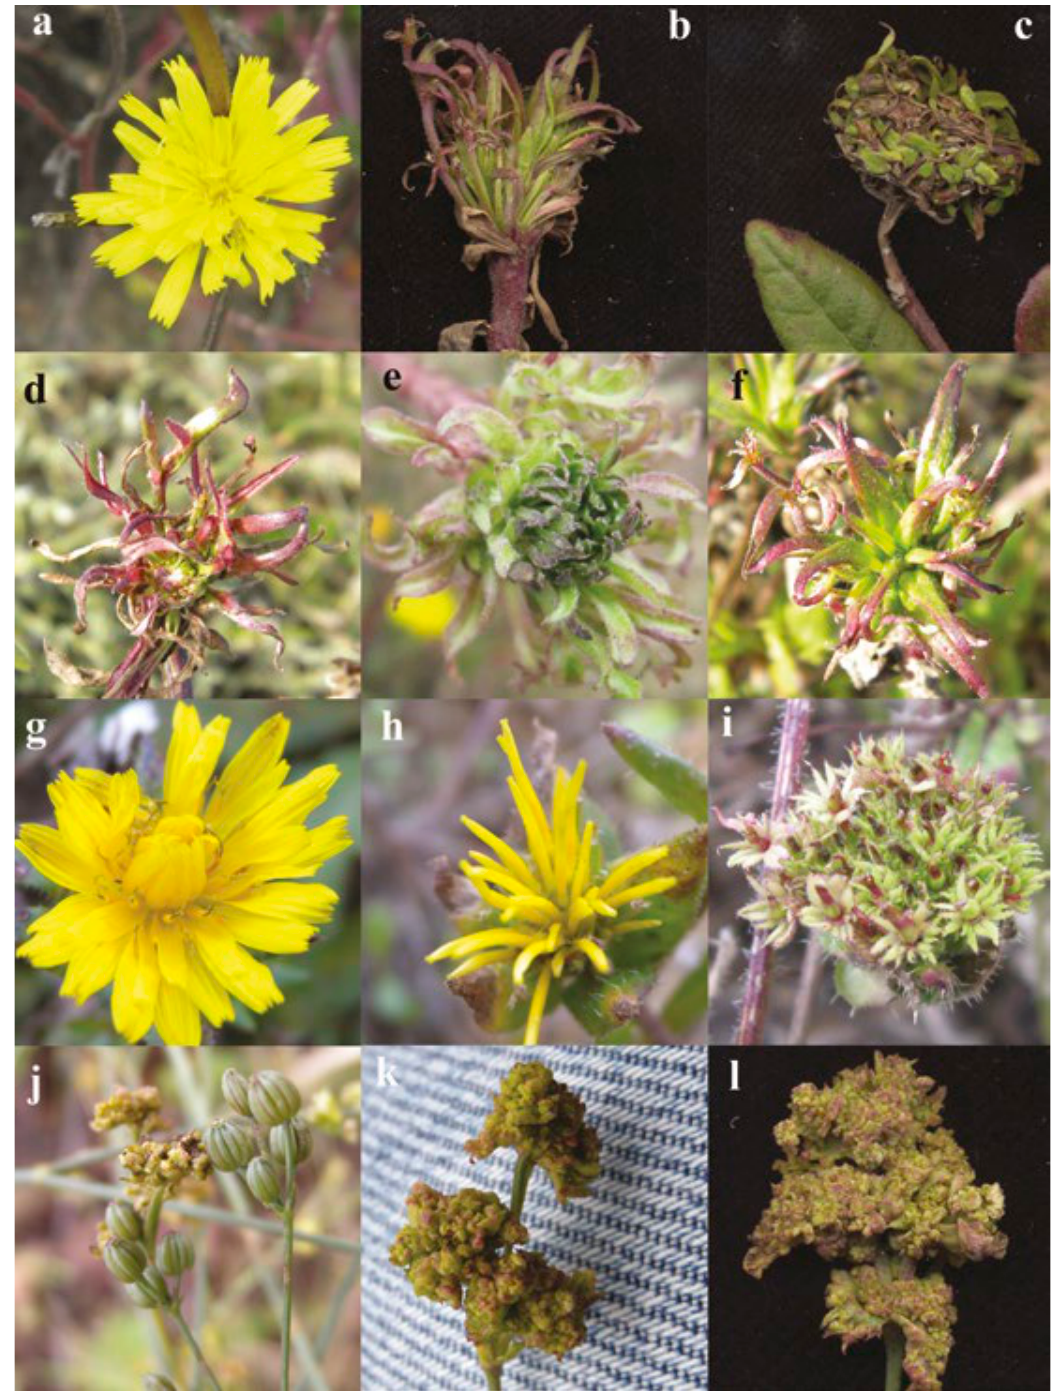
Figure 2. Examples of common symptoms shown by some of the wild herbaceous dicot taxa that were growing in the organic vineyards Cs and Fd in October 2010: b to f, Picris hieracioides ; h and i P. echioides ; k and l, Bupleurum tenuissimum . For comparison purposes the healthy organs of P. hieracioides , P. echioides and B. tenuissimum are shown in figures a, g and j,